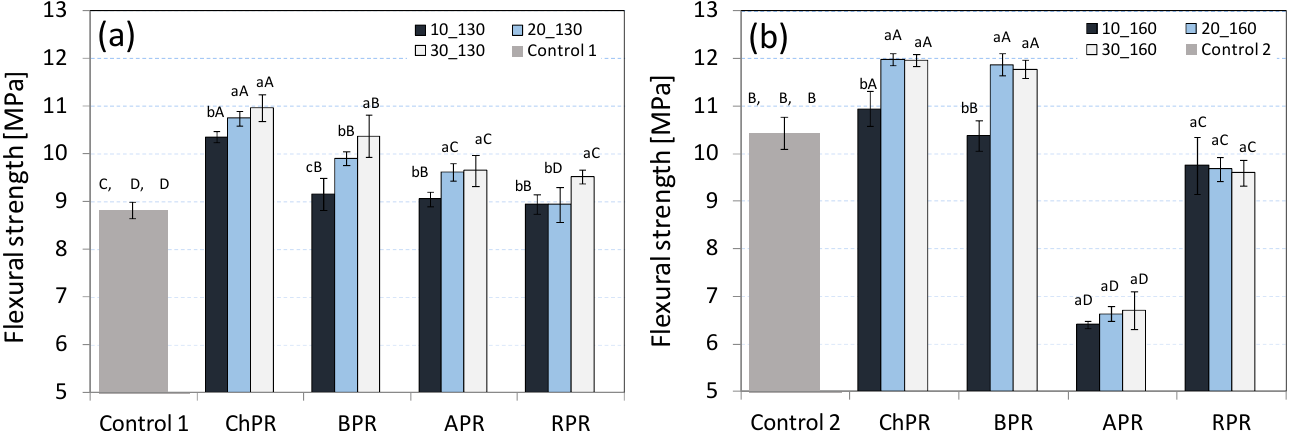
Figure 2. Average flexural strength values, for all biocomposites with each share of used pomace: ( a ) sample produced at temperature of 130 °C, ( b ) sample produced at temperature of 160 °C.